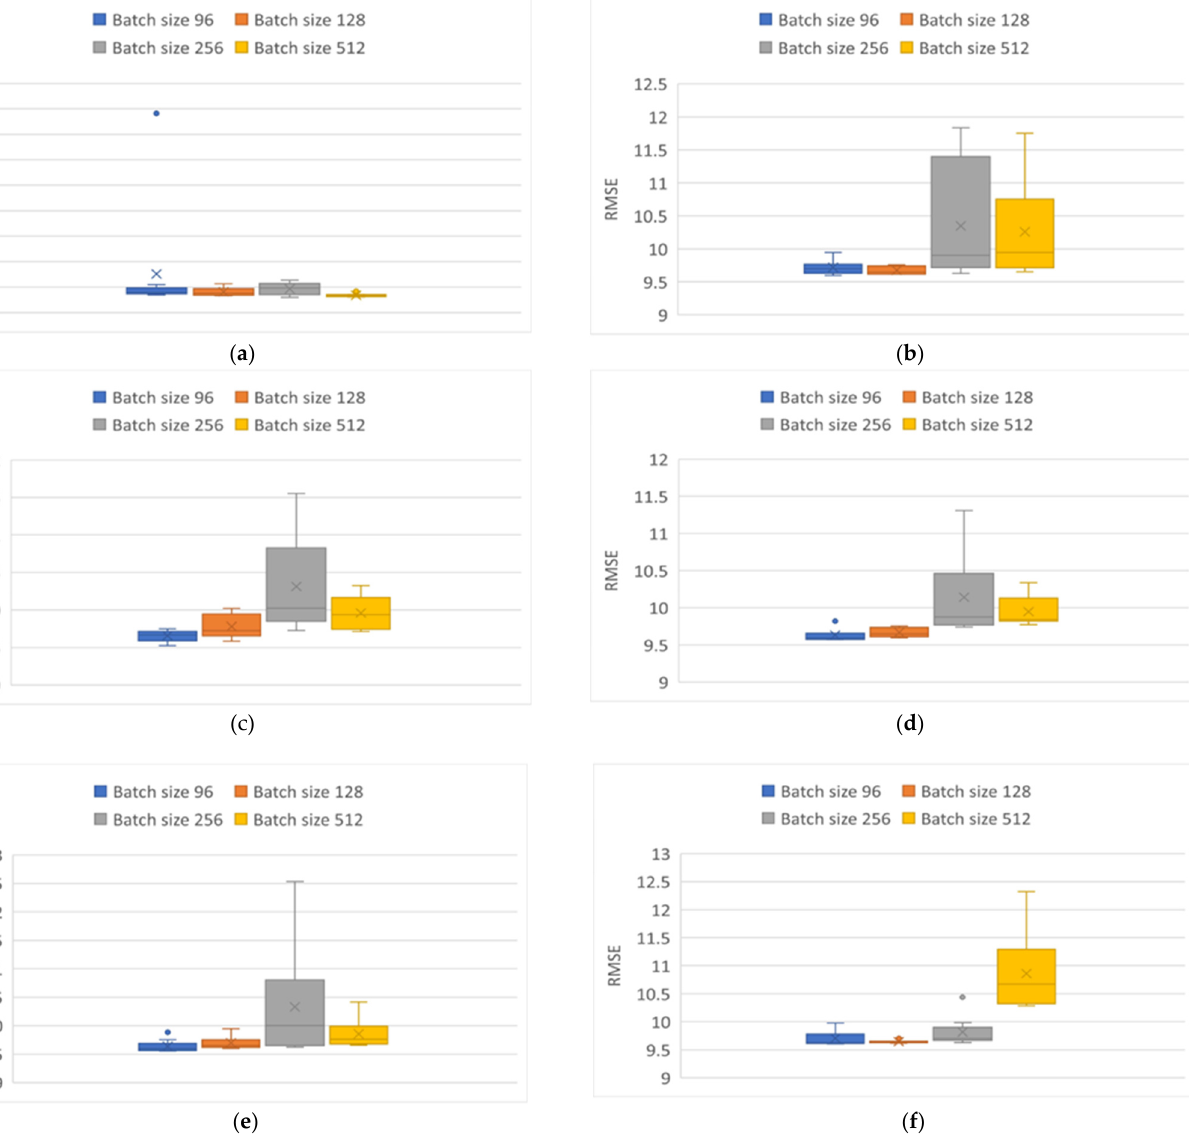
Figure 10. RMSE variability obtained from modeling PM 2.5 particles. ( a ) Elman neural network using Adam optimizer. ( b ) Elman neural network using Adamax optimizer. ( c ) GRU neural network using Adam optimizer. ( d ) GRU neural network using Adamax optimizer. ( e ) LSTM neural network using Adam optimizer. ( f ) LSTM neural network using Adamax optimizer.